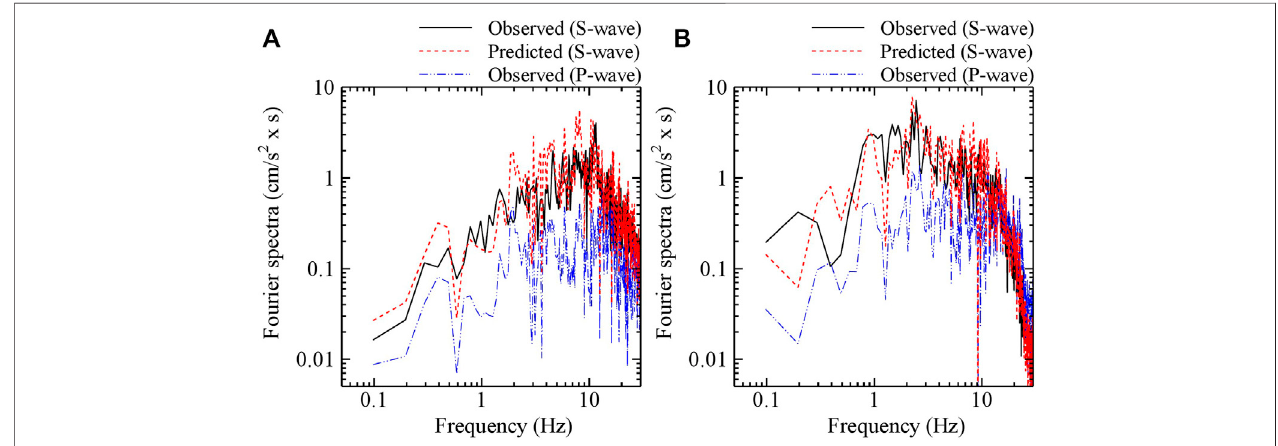
FIGURE8| PredictedFourierspectraofS-wavefortheearthquakeof Mj 5.9on11th/April2011atKSandSSstationswhoseaccelerationsareshownin Figure3 . Observed Fourier spectra of P-wave for the earthquake are also shown. (A) KS station (B) SS station.